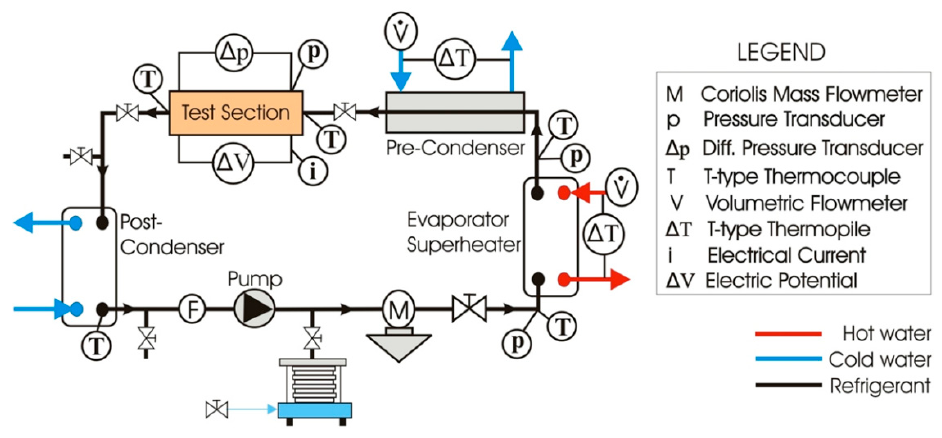
Figure 1. Schematic of the implemented